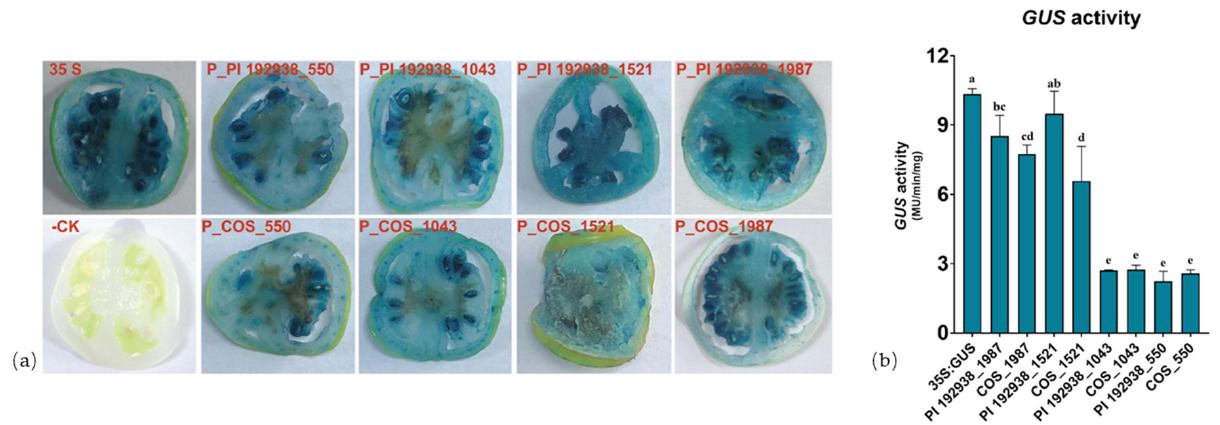
Figure 3. ( a ) Histochemical GUS staining of green tomato fruit. Transgenic lines carrying the GUS reporter gene under the control of the CaMV35S promoter were used as the positive control (35S) and untransformed tomato was used as the negative control ( ‐ CK); ( b ) GUS activity levels in green transformed tomato fruit. Values represent means ± SD from three repeats. Different lowercase letters indicate significant differences at p ‐ value < 0.05.